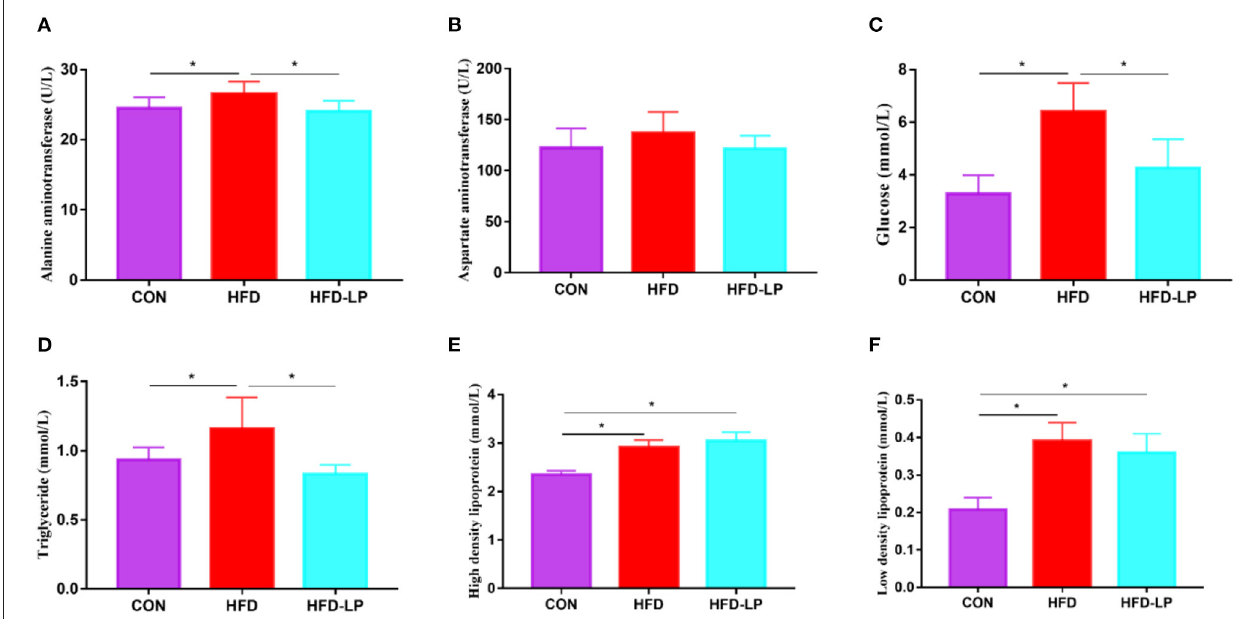
FIGURE 3 | Effects of Lactobacillus plantarum on the biochemical indexes of obese mice (A) the content of alanine aminotransferase in serum; (B) the content of aspartate aminotransferase in serum; (C) the Blood glucose level; (D) the content of triglyceride in serum; (E) the content of high-density lipoprotein in serum; (F) the content of low-density lipoprotein. Data are mean ± SD ( n = 8) and analyzed by one-way ANOVA. * p <